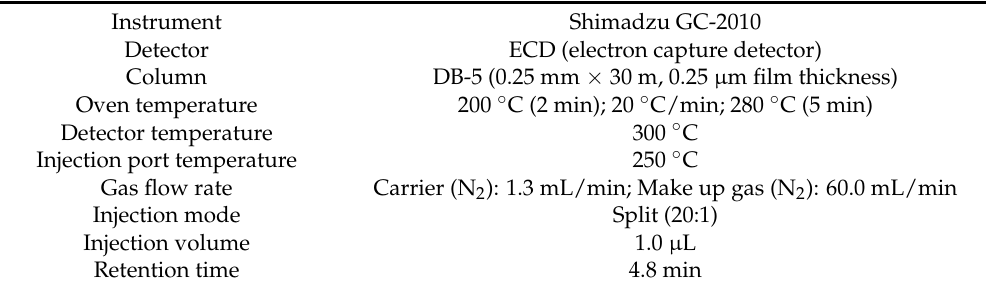
Table 1. Instrumental parameters for the analysis of